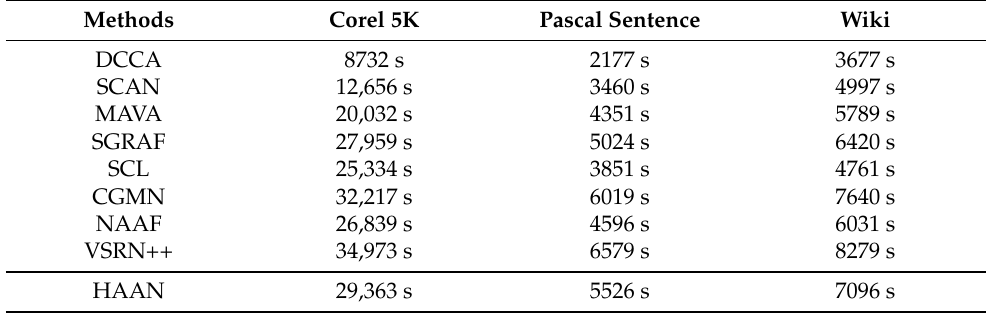
Table 4. Training time of our HAAN method and comparison methods on all